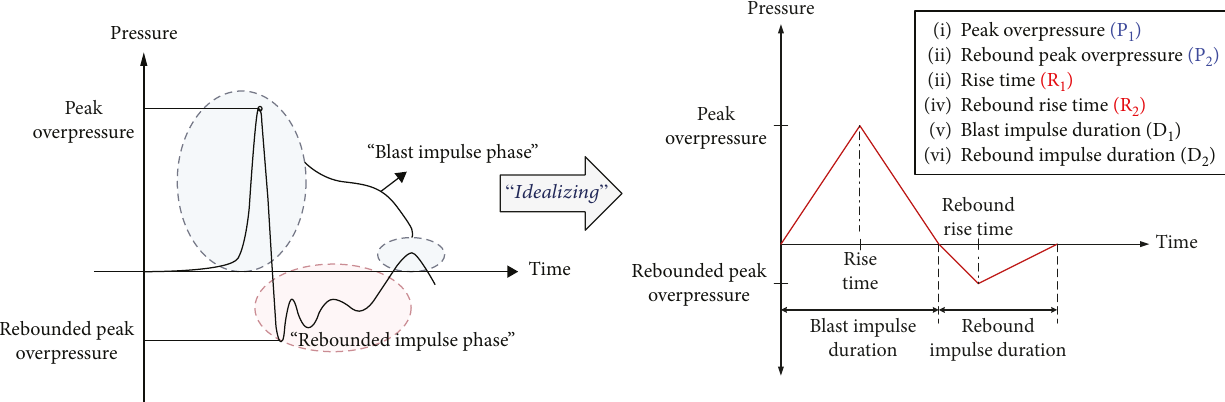
Figure 5: Idealized explosion wave pro fi le and the de fi nition of its risk